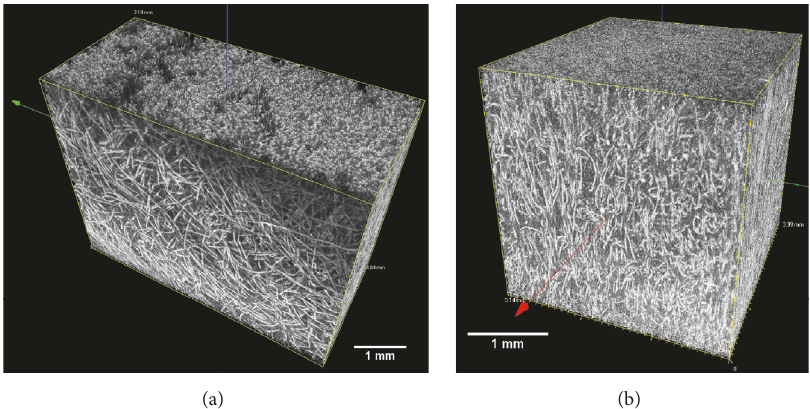
Figure 6: Synchrotron-radiation based 𝜇 -CT micrographs of a compression molded (a) and an injection molded lyocell/PLA composite (b).